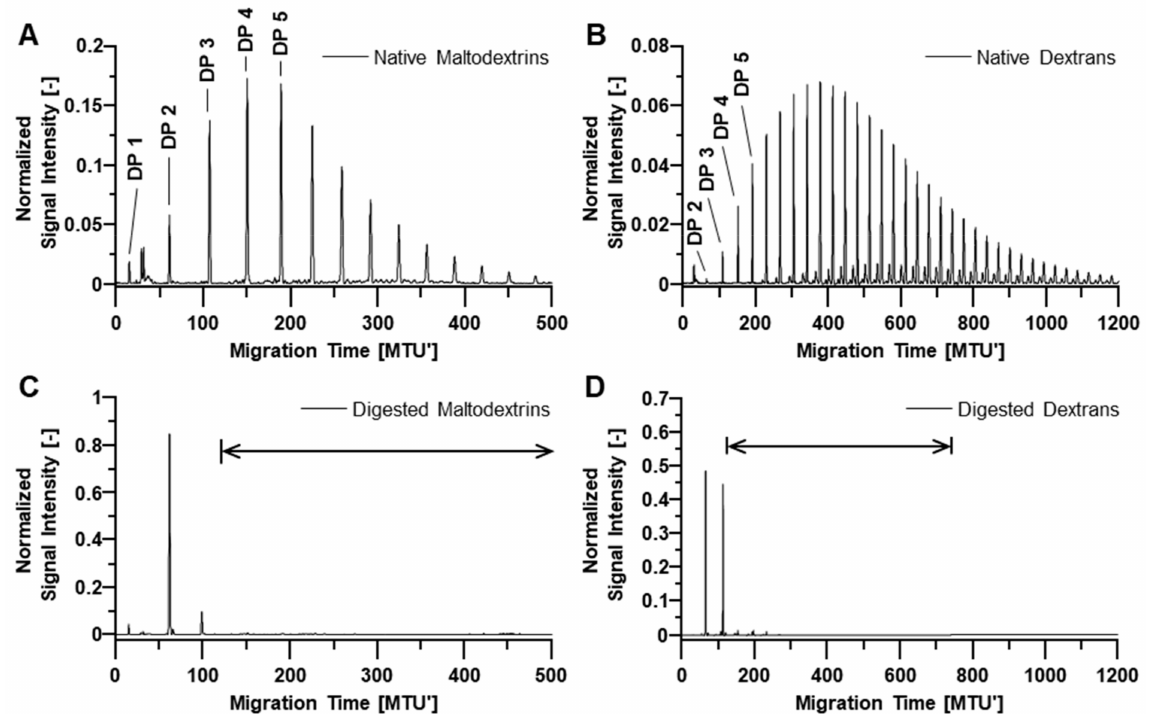
Figure 2. APTS-labeled maltodextrins ( A ) and dextrans ( B ) analyzed by xCGE-LIF before and after en- zymatic treatment with glucoside hydrolases. Maltodextrins were degraded by glucoamylase P (GAP) with 0.017 U/ µ L ( C ). Dextrans were degraded by dextranase from Chaetomium erraticum (DxChe, Panel D ). APTS-labeled maltodextrins and dextrans were formulated in disodium phosphate-citrate buffer at pH 5 for enzymatic degradation. Interfering oligosaccharides (Degree of Polymerization DP ≥ 4) could be successfully degraded to non-interfering oligosaccharides (DP1, DP2 and DP3) within an incubation time of 30 min. Normalized signal intensity (with sum of picked peak heights = 1) was plotted over aligned migration time in Migration Time Units (MTU’). Maltodextrin and dextran peaks are exemplarily annotated up to DP5 in ( A , B ). The migration time range of N -glycans is indicated by an arrow in ( C , D ). Data analysis was performed using